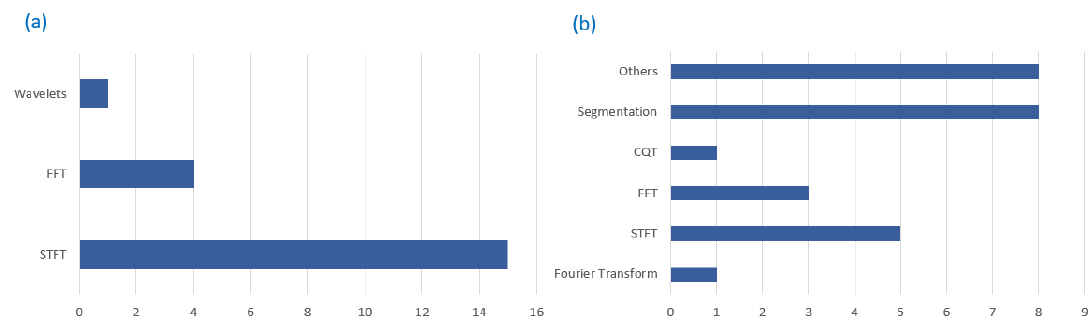
Figure 10. Audio pre-processing techniques used in ( a ) bioacoustics and ( b ) general acoustics studies.